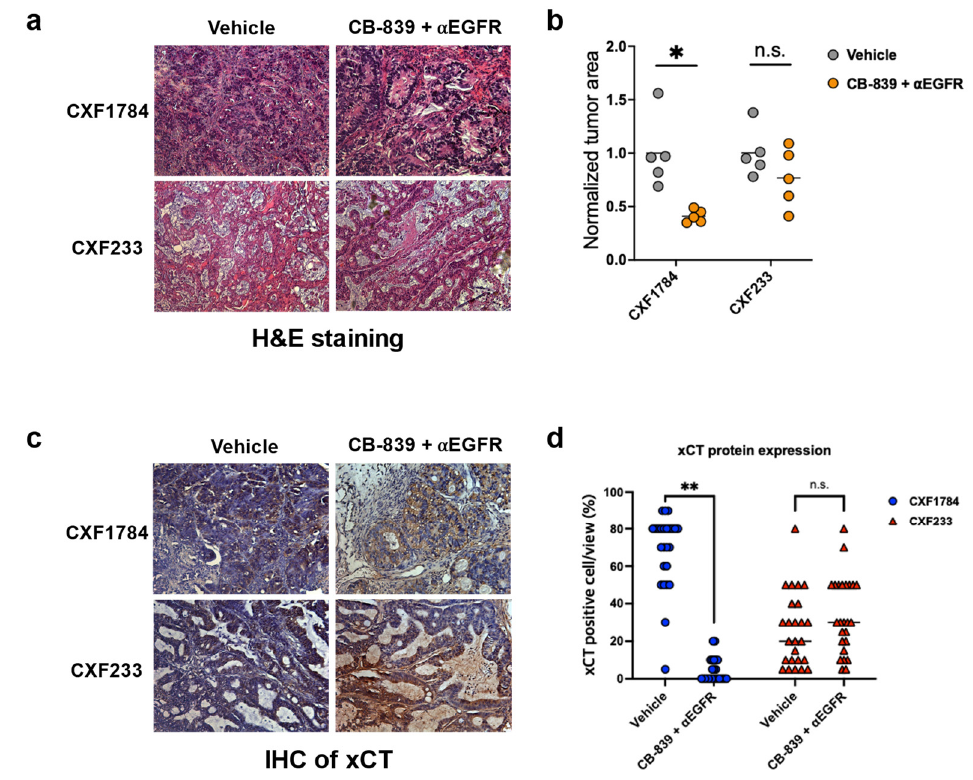
Figure 4. Histology. ( a ) Representative H&E images of tumor growth in PDX models (20 × magnification). ( b ) Alive tumor ratio analysis results. Each tumor area was normalized by the mean area of the vehicle group for each PDX case. ( c ) Representative immunohistochemical staining results of xCT in PDX models (20 × magnification). ( d ) Quantitative analysis of xCT IHC positivity ( n = 5). Bar on dot plots indicates mean value and statistical significance is defined as follows: n.s. (not significant), * p < 0.01, and ** p <